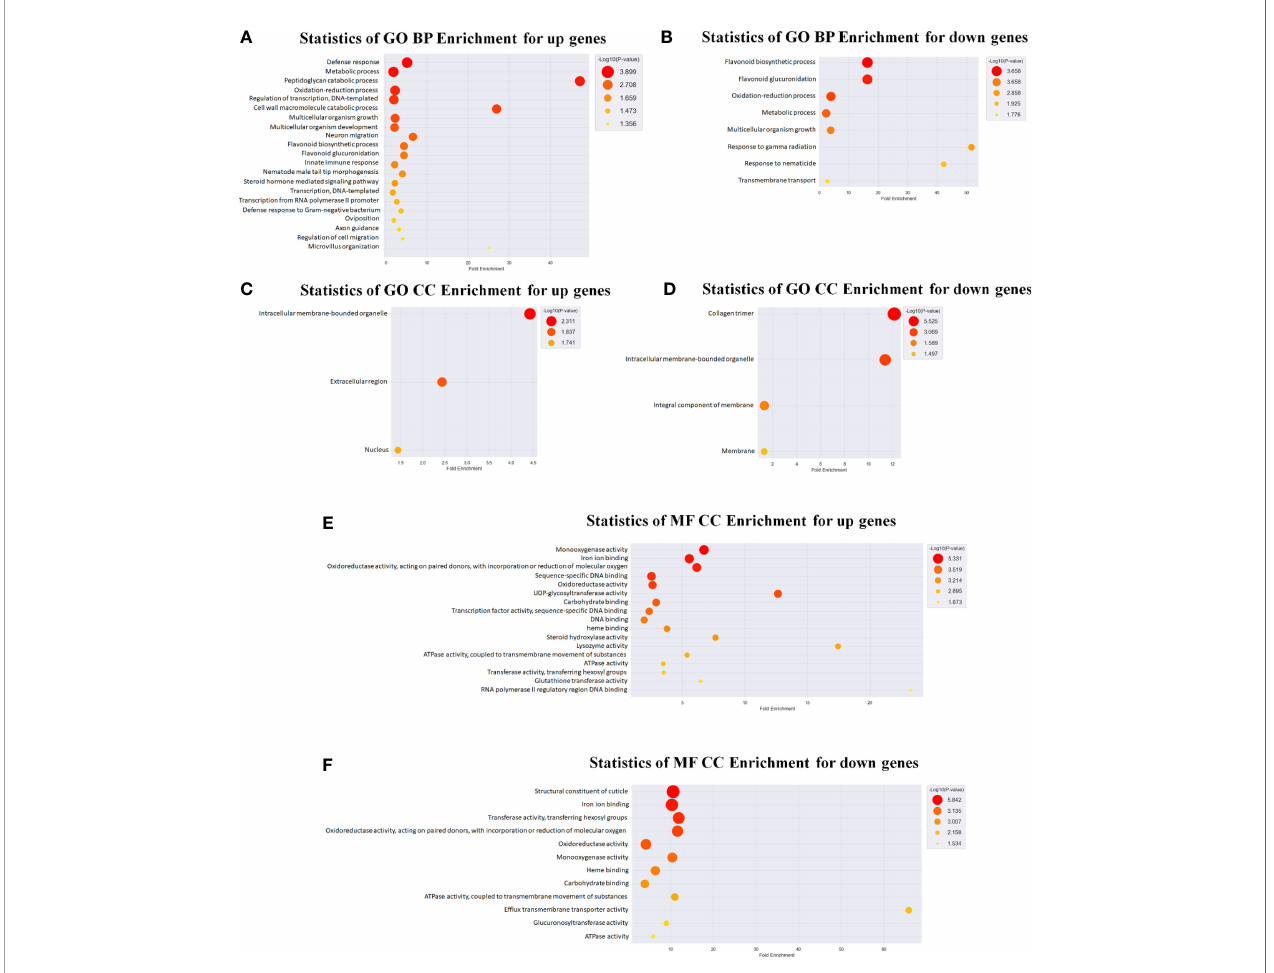
FIGURE 4 | Gene ontology (GO) analysis in C. elegans exposed to LGG. GO analysis of differentially expressed genes was also performed. GO analysis was performed using the genes whose expression levels were changed by ≥ 3 folds compared with the control levels. Genes were classi fi ed based on DAVID (https:// david.ncifcrf.gov/) and Medline databases (http://www.ncbi.nlm.nih.gov/). Data mining and graphic visualization were performed using ExDEGA (E-Biogen, Inc., Seoul, Korea). Dot plot shows the upregulated and downregulated genes GO terms (FDR <0.05) sorted by the most signi fi cant. The size and color of the dot shows the pathway enrichment signi fi cance. (A, B) Genes were classi fi ed into different hierarchical categories based on biological process, (C, D) cellular component and (E, F) molecular